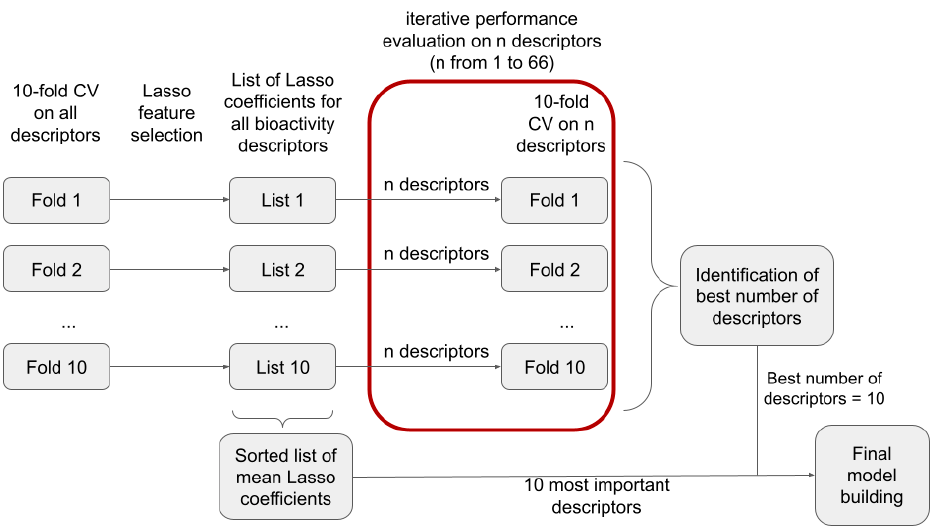
Figure 1. Schematic representation of the workflow for feature selection.